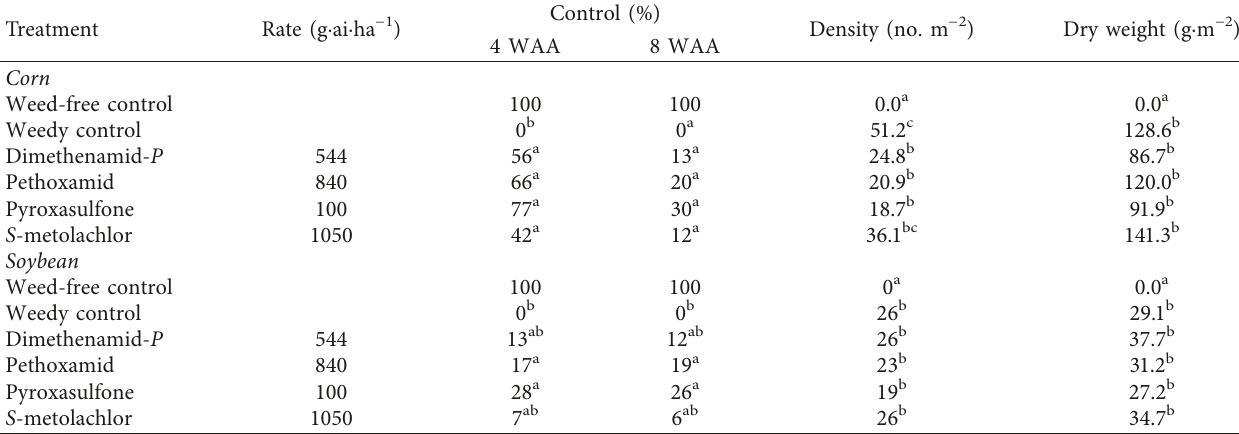
Table 3: Control, density, and dry weight of common ragweed in corn and soybean treated with VLCFA inhibitor herbicides, applied preemergence (PRE), near Exeter and Ridgetown (2015–2017) a